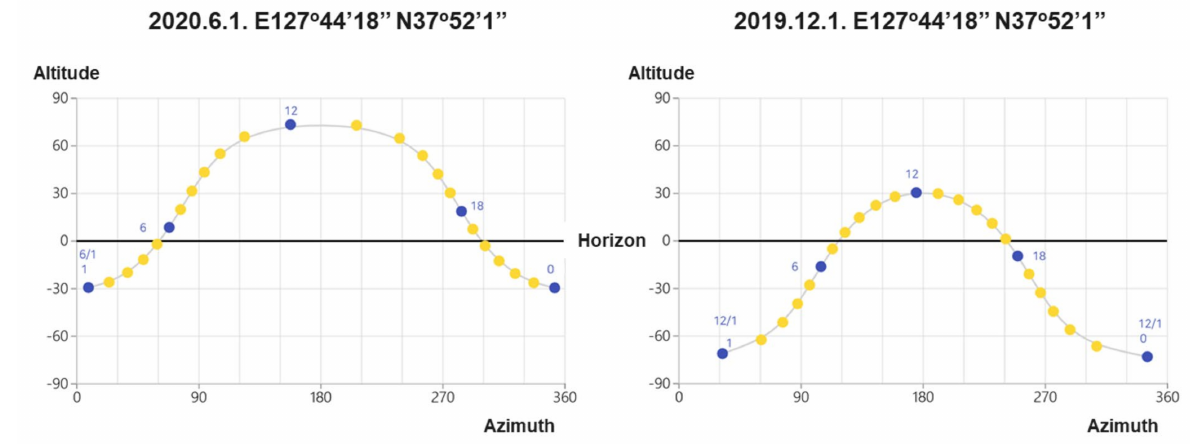
Figure 3. Altitude and azimuth angles of the sun in Korea.